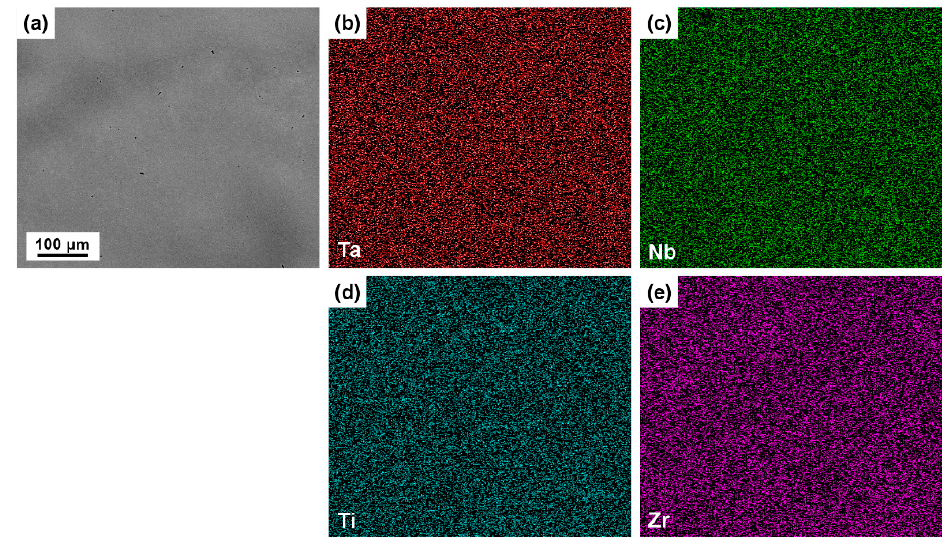
Figure 3. ( a ) SEM image of the TaNbTiZr RHEA bars; EDS mappings of ( b ) Ta, ( c ) Nb, ( d ) Ti, and ( e ) Zr,